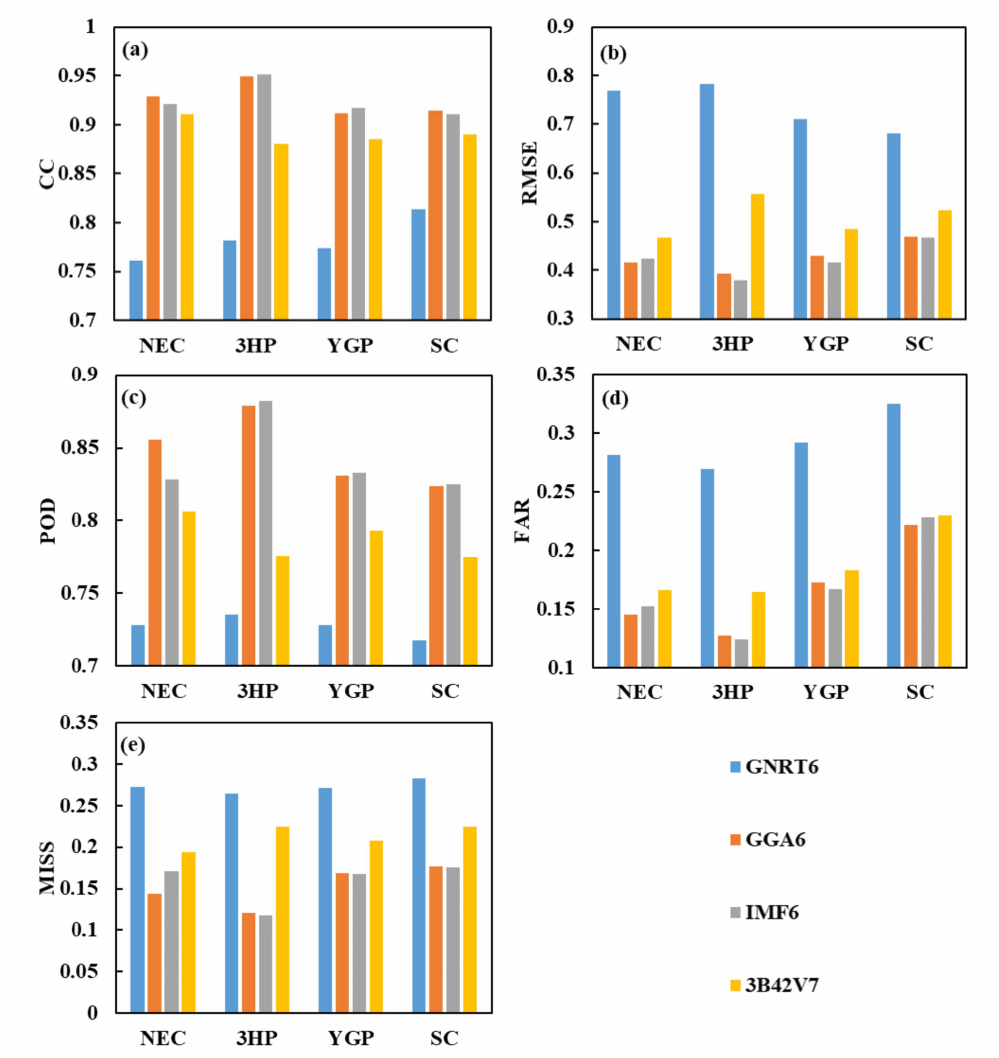
Figure 11. Temporal ( a ) CC, ( b ) RMSE, ( c ) POD, ( d ) FAR and ( e ) MISS of the regional averaged drought indices for the four drought-affected